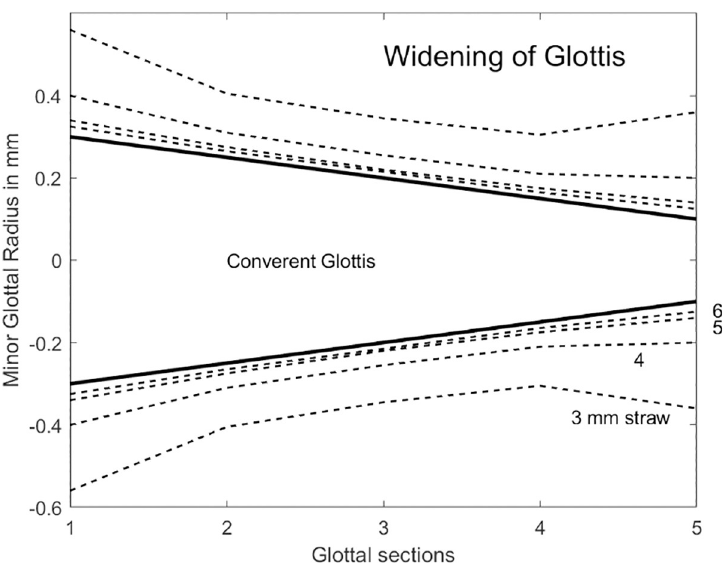
Fig 5. Expansion of the minor diameters of the elliptical glottal sections with 2.5 kPa lung pressure and 3.0, 4.0, 5.0, and 6.0 mm tube diameters at the mouth. The vertical to horizontal aspect ratio is 6.67 (5 sections have 8 mm length).